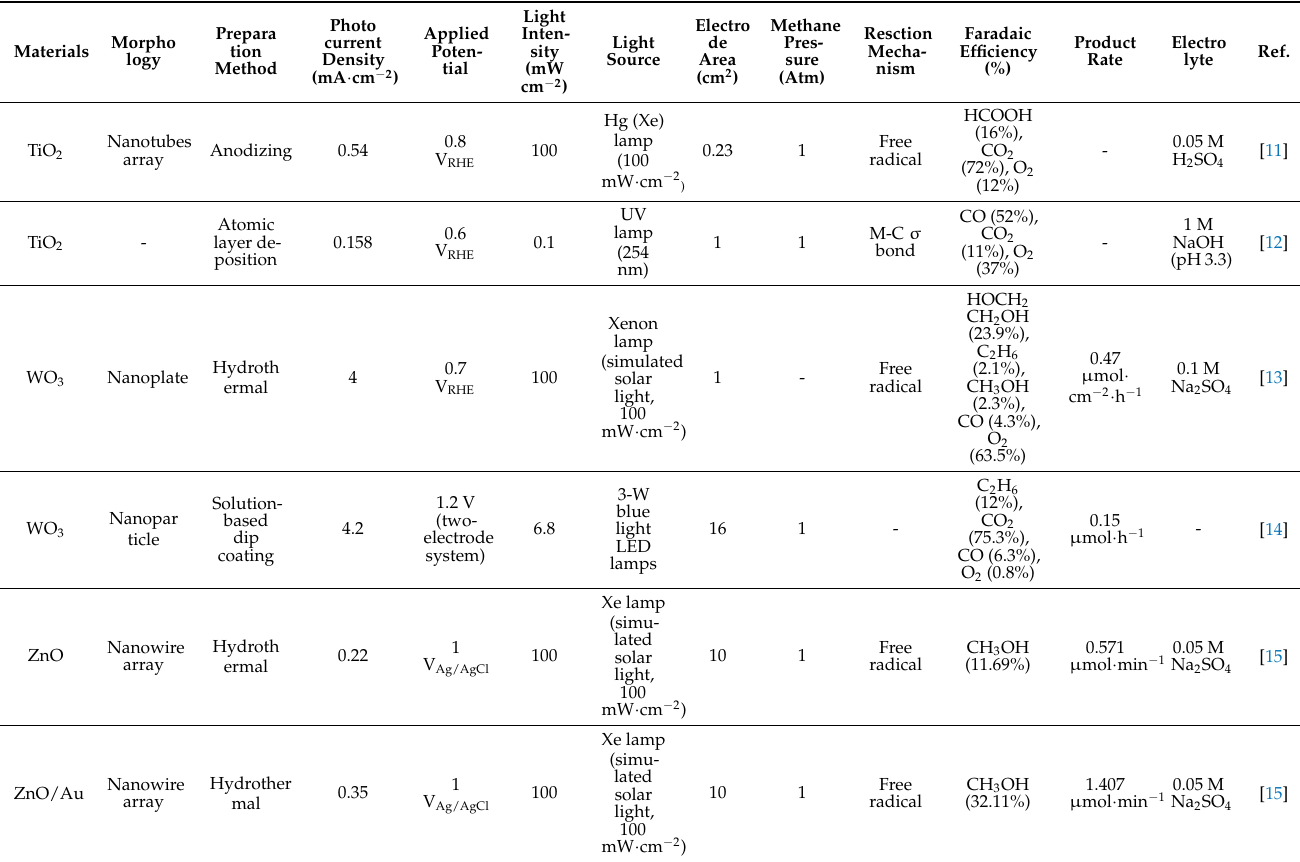
Table 2. Comparison of different PEC methane oxidation